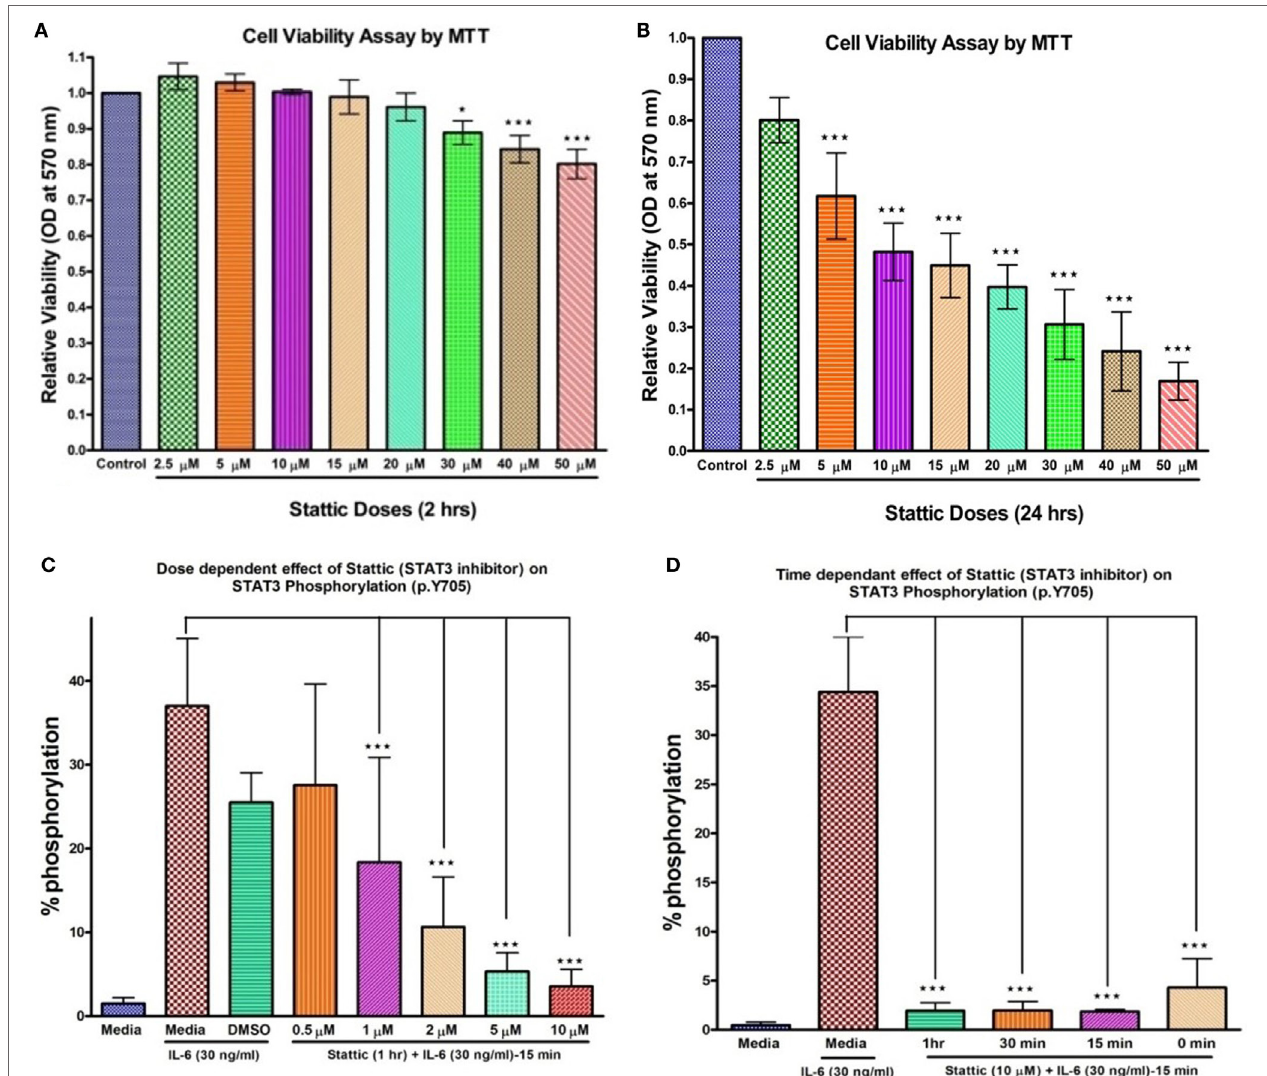
FigUre 3 | Bar graphs showing effect of stattic at different doses on cell viability and STAT3 phosphorylation on healthy controls peripheral blood mononuclear cells. Cell viability: (a) at 2 h, no effect on cell viability was observed except at high doses where growth inhibition was evident (B) at 24 h, growth was inhibited in